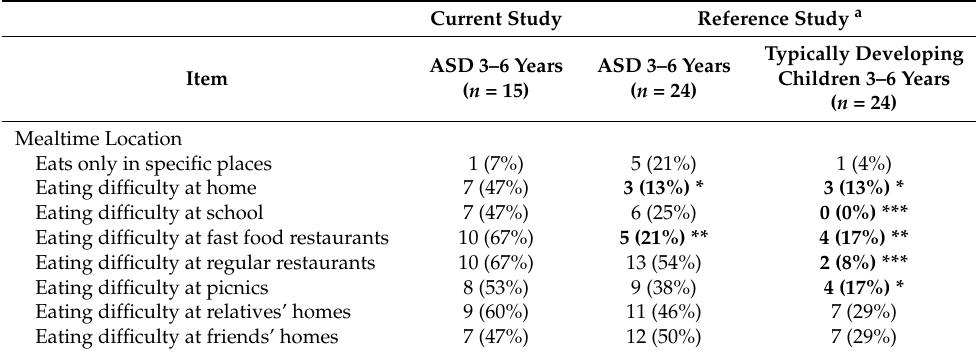
Table 5. Eating difficulties at mealtime locations.